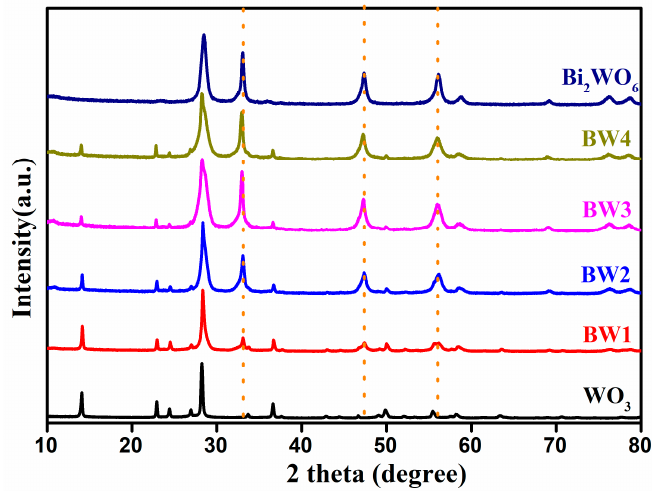
Figure 1. X-ray powder diffraction (XRD) patterns of pure WO 3 , Bi 2 WO 6 , and Bi 2 WO 6 /WO 3 samples.